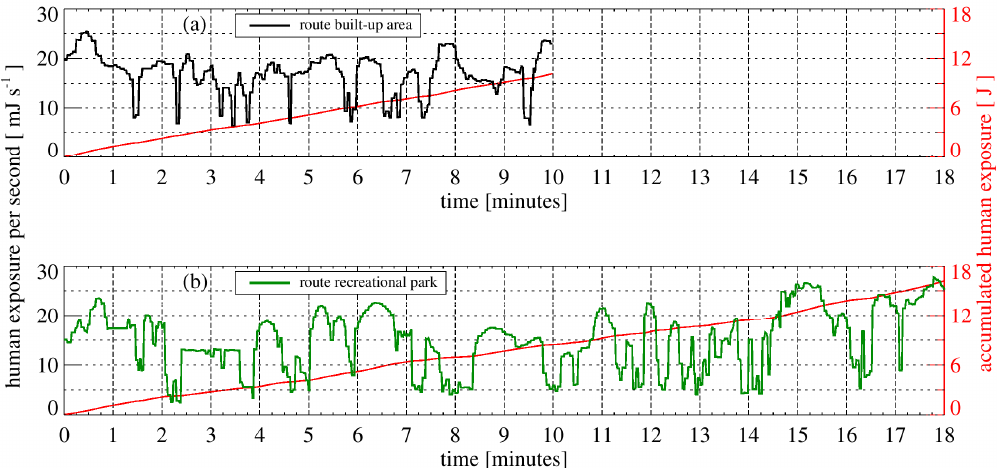
Figure 6. The calculated vitamin D 3 -weighted exposure of a human with summer clothing walking to the university cafeteria on the two selected routes, through a built-up area ( a ) and through a recreational park ( b ), on 21 June is shown as a function of the time. Additionally, the accumulated exposure is displayed in